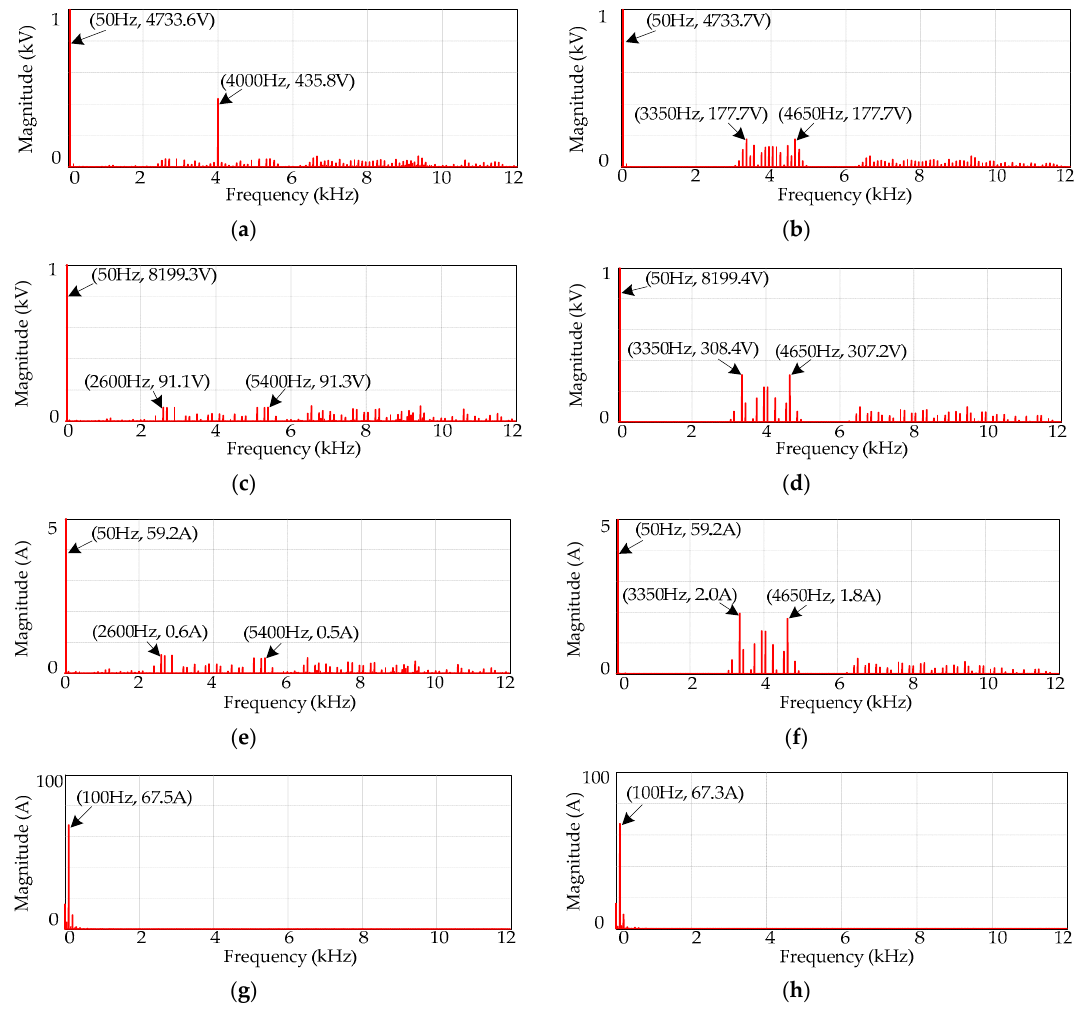
Figure 6. Comparison of harmonic spectra between DCPDPWM and PSCPWM methods with the circulating current harmonics cancellation scheme: ( a ) phase voltage of DCPDPWM; ( b ) phase voltage of PSCPWM; ( c ) line-to-line voltage of DCPDPWM; ( d ) line-to-line voltage of PSCPWM; ( e ) phase current of DCPDPWM; ( f ) phase current of PSCPWM; ( g ) circulating current of PDPWM; and ( h ) circulating current of PSCPWM. Table 2. Comparison of simulation results between DCPDPWM and PSCPWM methods with the circulating current harmonics cancellation scheme. THD : total harmonic distortion. Modulation Methods DCPDPWM